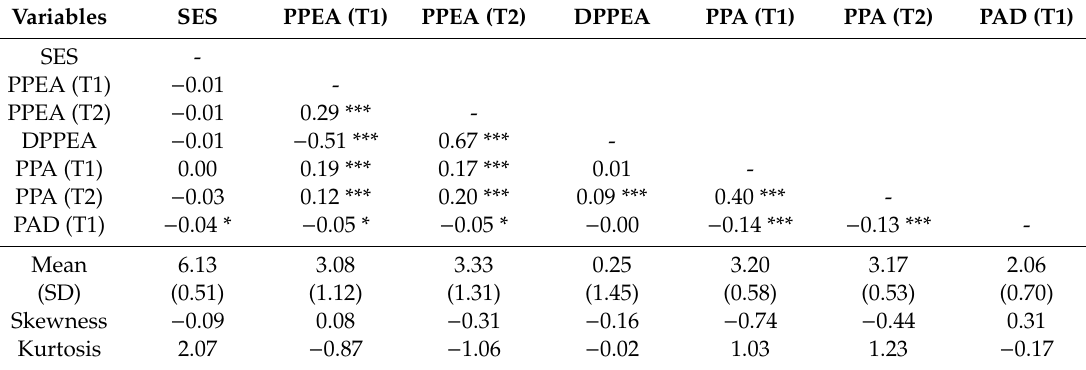
Table 2. Correlation and statistical analyses of observed variables for Cohort 2.